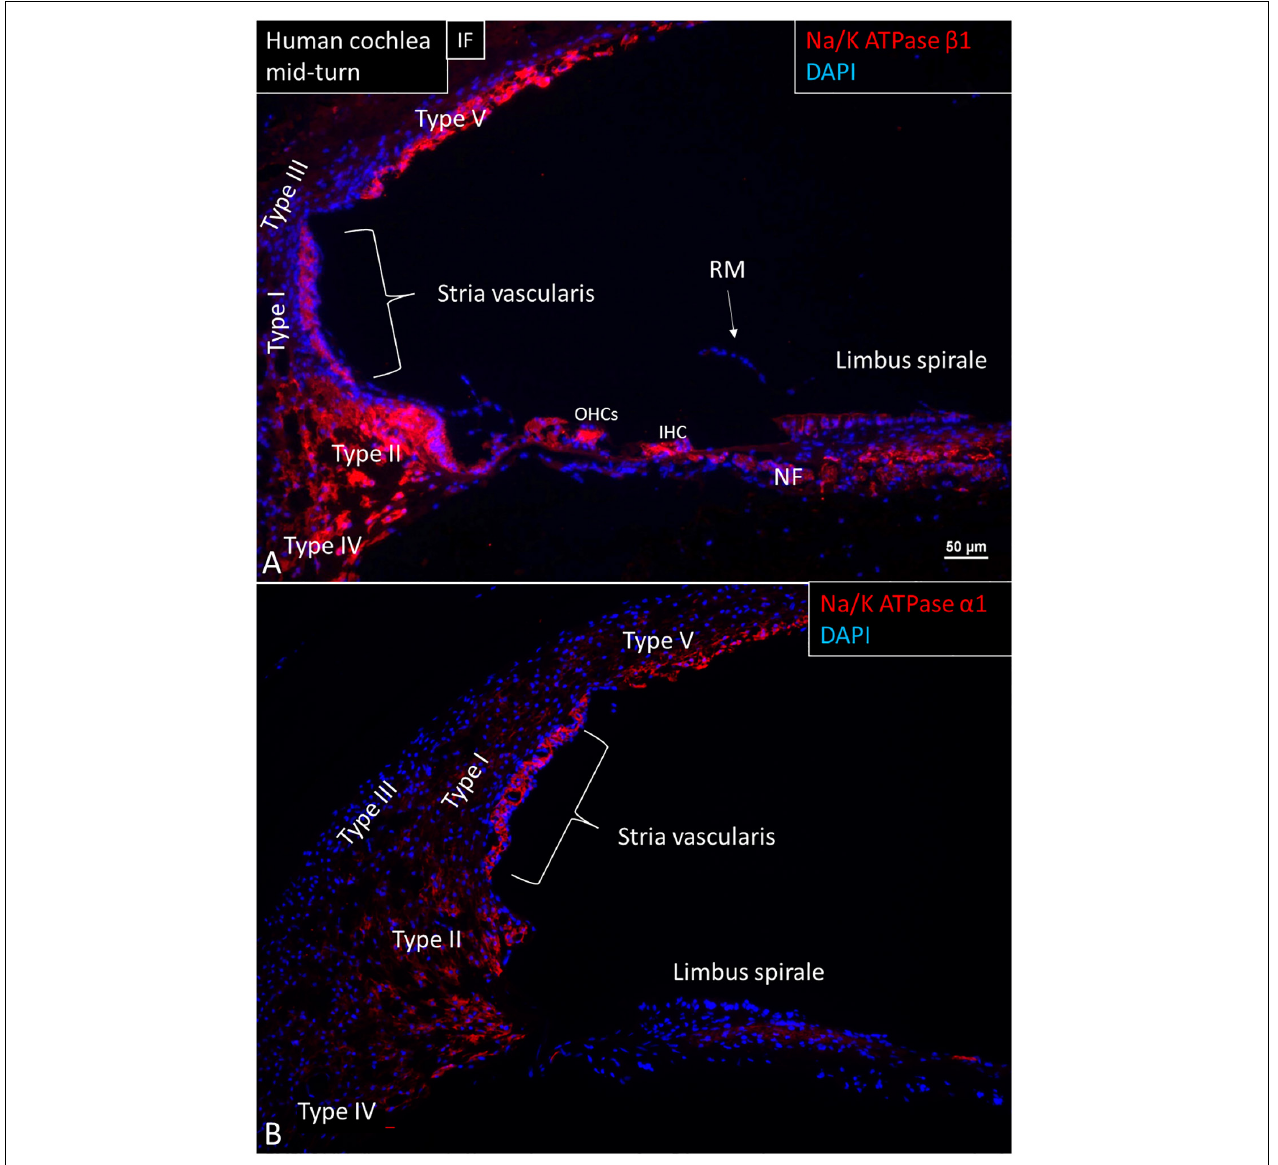
FIGURE 1 | Immunofluorescence (IF, A ) and confocal microscopy (B) of cross-sectioned human cochlea shows expression of NKA β 1 and NKA α 1. The marginal cells, type II, IV, and V fibrocytes, outer sulcus, Hensen cells, interdental cells, spiral limbus fibrocytes, and auditory neurons express NKA β 1 but not type I and III fibrocytes, RM and the tympanic covering layer. The NKA α 1 subunit is strongly expressed in the SV marginal cells but less in type IV and V fibrocytes. OHCs, outer hair cells; IHC, inner hair